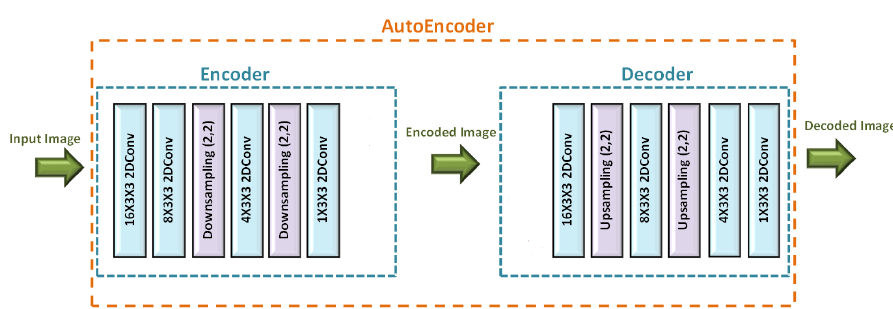
Figure 5. Autoencoder architecture.